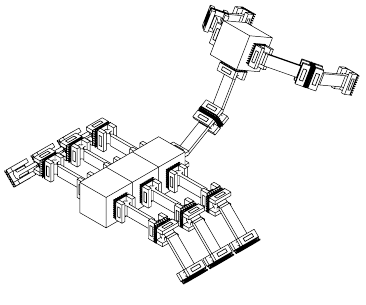
Figure 1. The concept of a chain style modular robot with dielectric elastomer bender